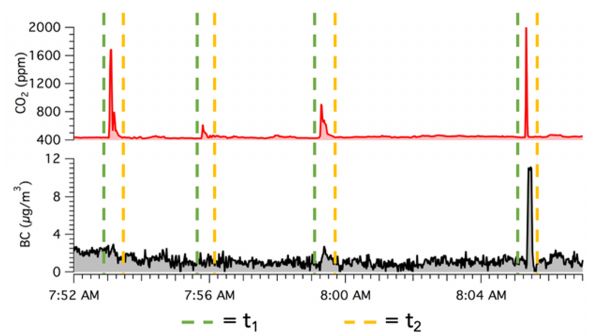
Figure A1. Concentration time series showing example peaks from roadside sampling of truck exhaust. The integration bounds (t 1 , t 2 ) for determining fuel-based emission factors by the carbon balance method for each pollutant peak event are shown by dashed green and yellow lines. Minor tick marks show increments of 15